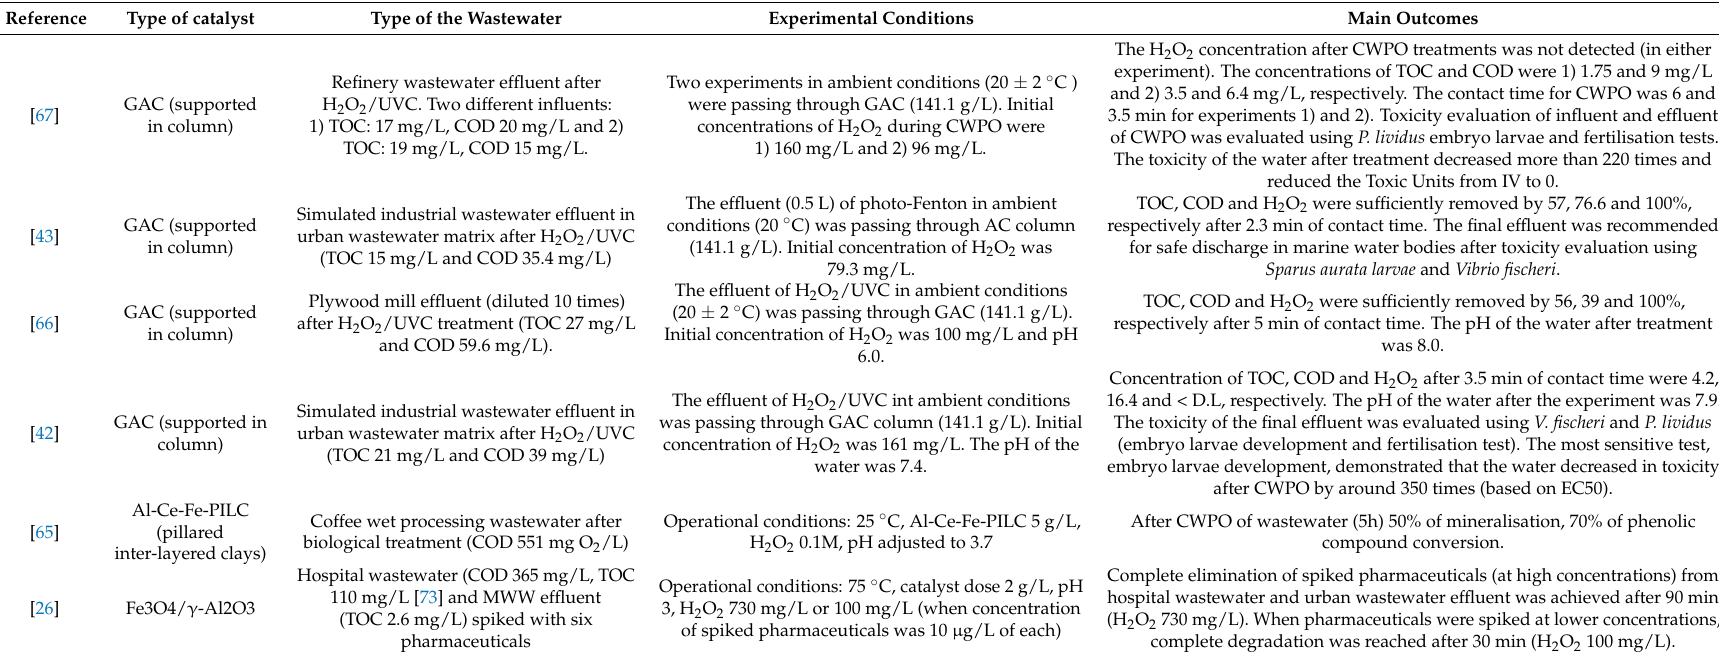
Table 2. Catalytic wet peroxide oxidation (CWPO) as a